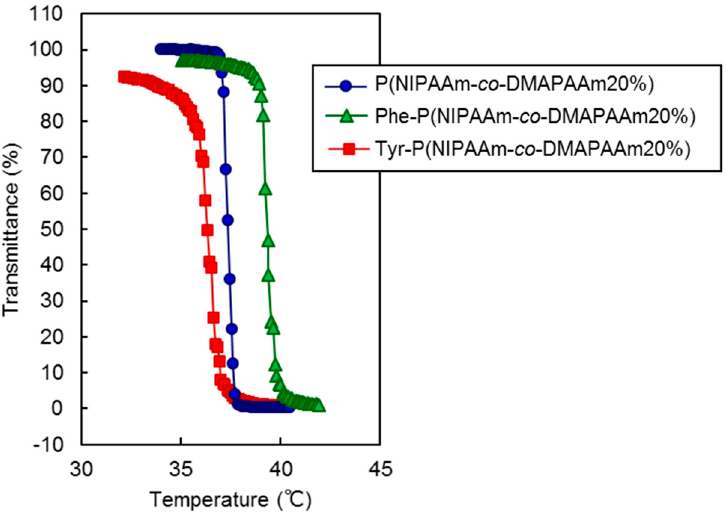
Figure 2. Phase transition profiles of prepared polymers.